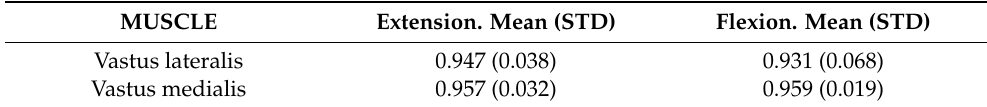
Table 4. Spearman’s correlation coefficients between measured EMG and muscle forces estimated by SGM. ( n = 75).